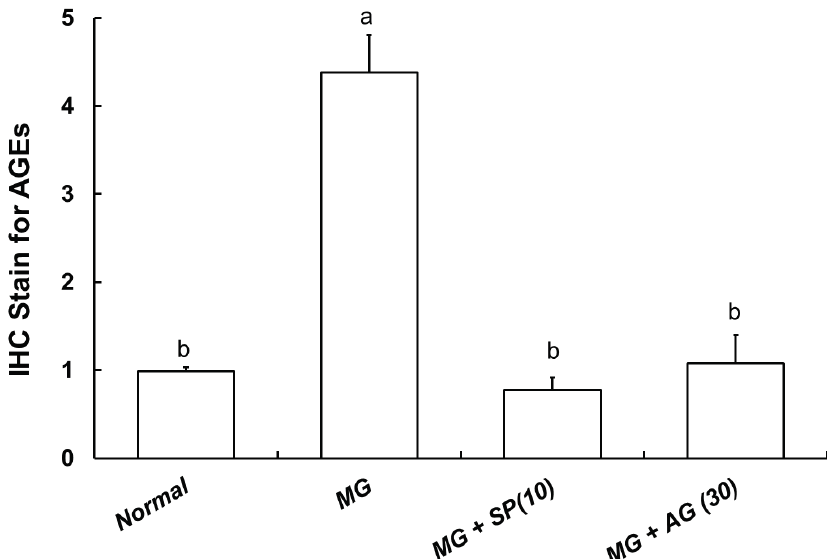
Figure 5. The IHC stain for hepatic AGEs levels. Normal: deionized water;